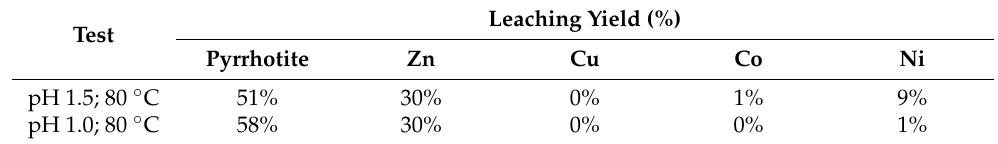
Table 3. Calculated leaching yields of pyrrhotite, Zn, Cu, Co and Ni in tests conducted at 80 ◦ C.